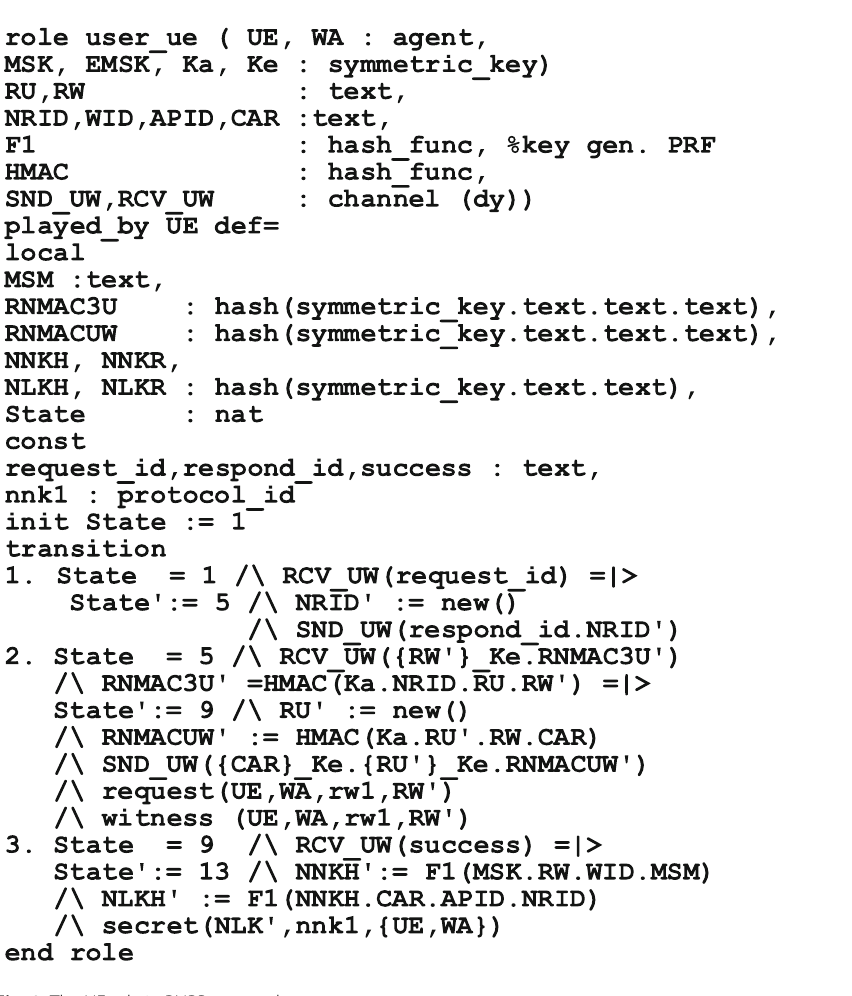
Fig. 8 The UE rule in RNRP